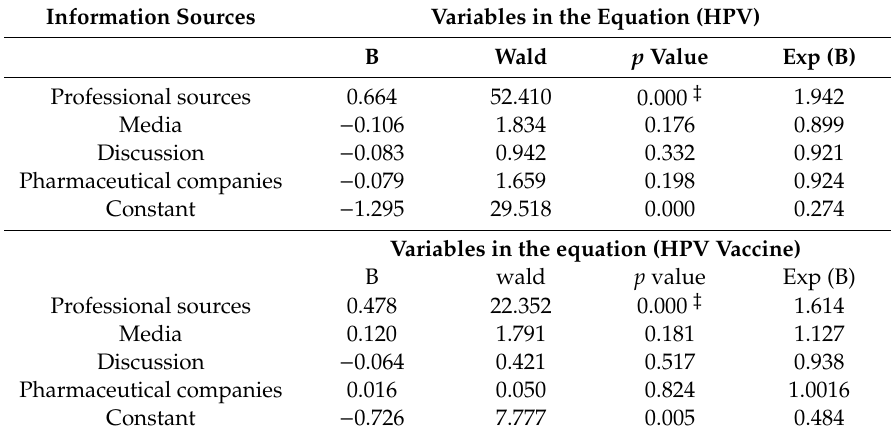
Table 4. The relationship between the knowledge level and frequency of di ff erent information sources